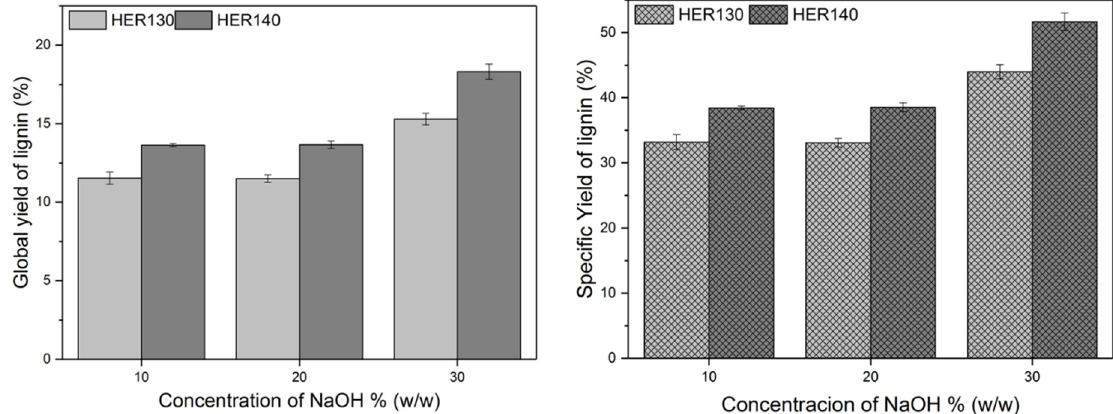
Figure 1. Global (left) and specific (right) lignin yields after alkaline treatment of HER130 and